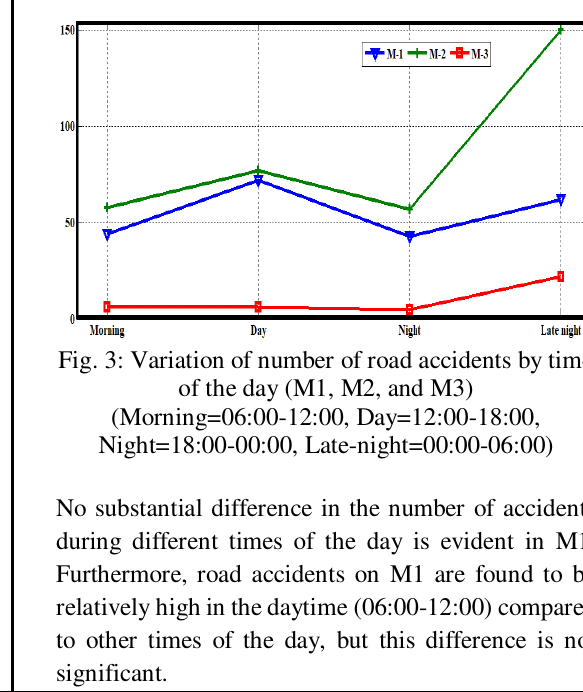
Fig. 3 represents the time-wise trend of road accidents on M1, M2, and M3.